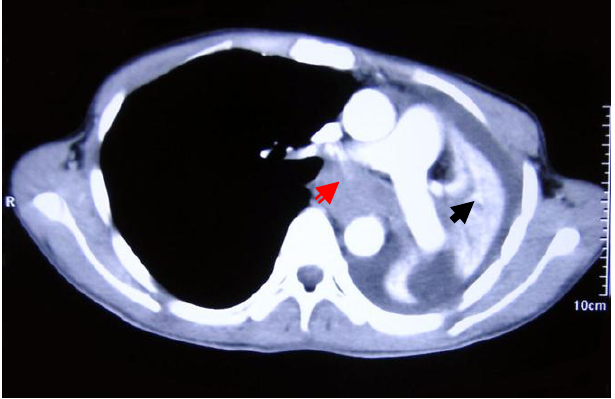
FIGURE 1. A contrast-enhanced CT scan shows a mass (red arrow) in the middle mediastinum compressing the left main bronchus, resulting in a complete atelectasis of the left lung (black arrow) and a mediastinal shift toward the left. A pleural effusion is